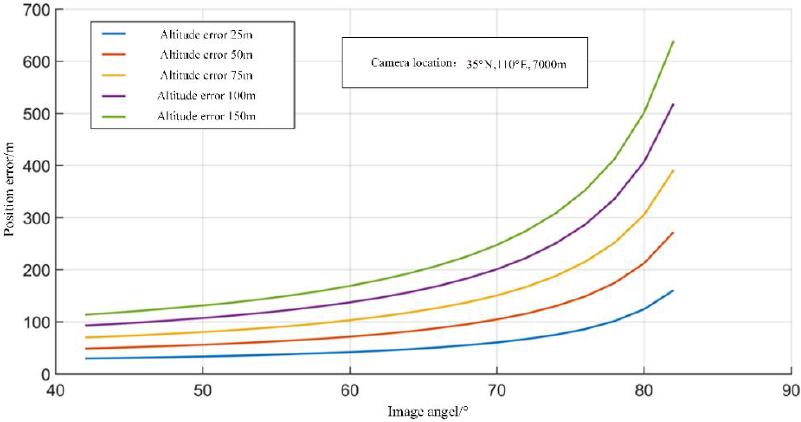
Figure 13. Positioning errors caused by target elevation error.